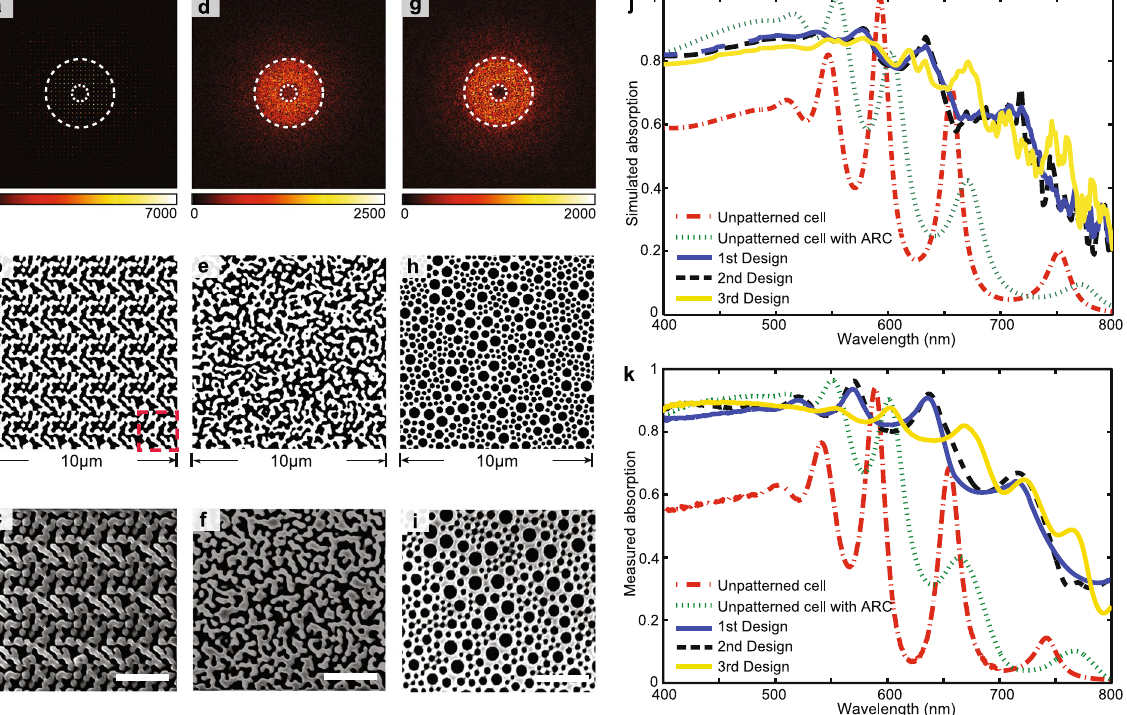
Figure 4. Broadband optimization results. The optimized Fourier spectra, bitmap images, and SEM images of the quasi-random nanostructures generated differently from the same optimized SDF. ( a – c ) Quasi-random structure constructed by repeating a single unit cell in the dashed window. ( d – f ) Quasi-random structure with channel-type morphology. ( g – i ) Quasi-random structure with disk-type morphology. ( j ) Simulated absorption spectra of the three quasi-random nanostructures from the identical optimized SDF, the unpatterned cell, and the unpatterned cell with ARC layer. ( k ) Experimentally measured absorption spectra of the five cells. Scale bars in ( c , f , i ): 2 µ